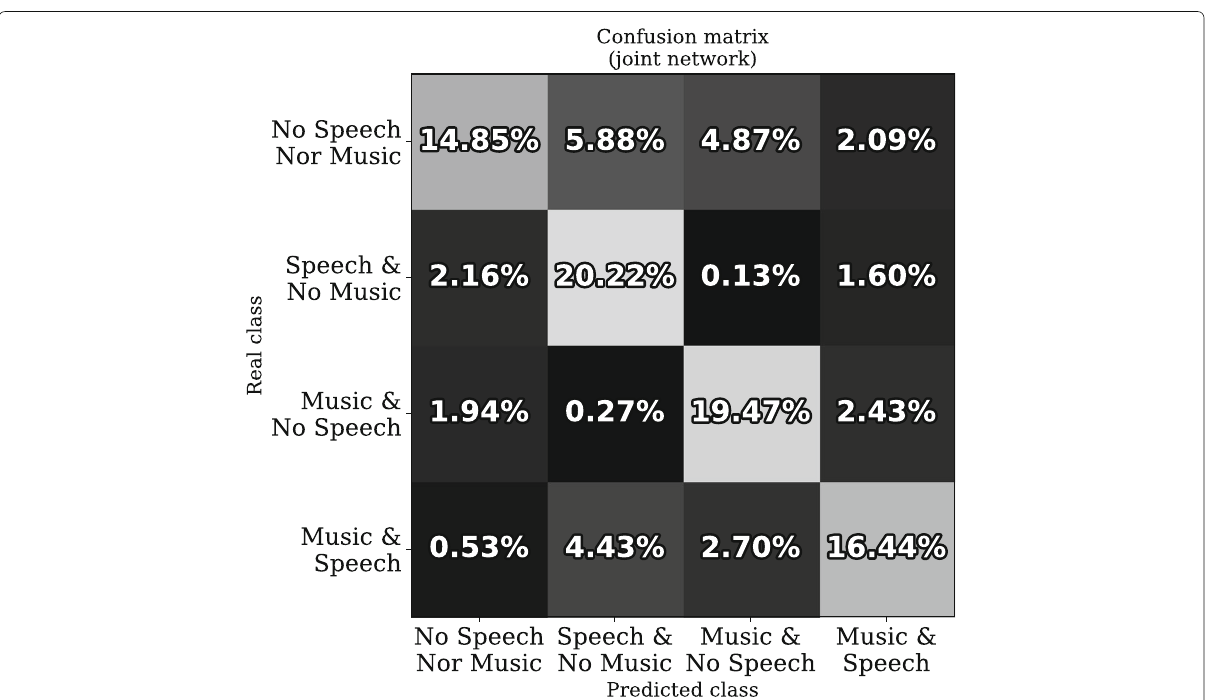
Fig. 9 Four-class confusion matrix of the best network setting for speech and music event detection (C2-LSTM model with L = 6 and N = 256). The percentages indicate the total amount of test segments in each possible real class-predicted class combination